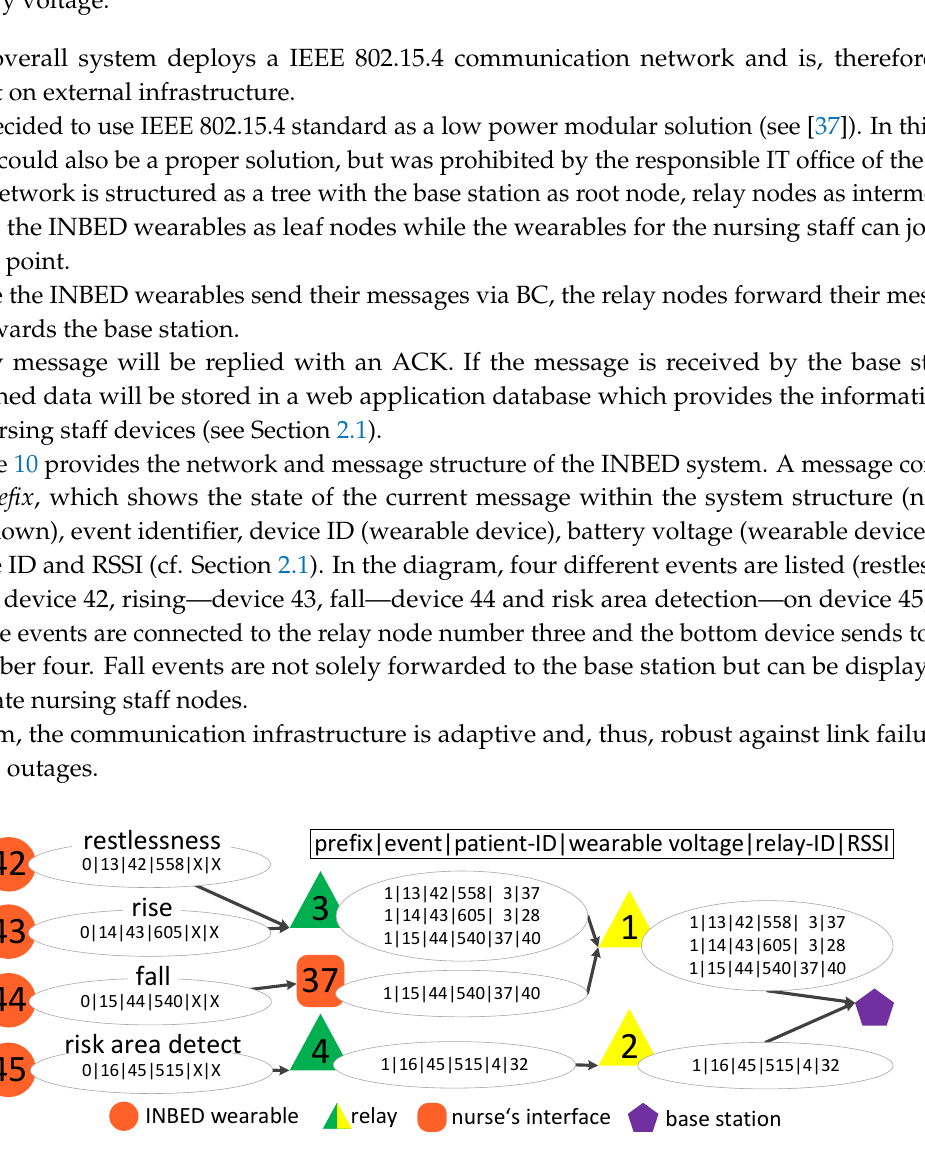
Figure 10. INBED system communication